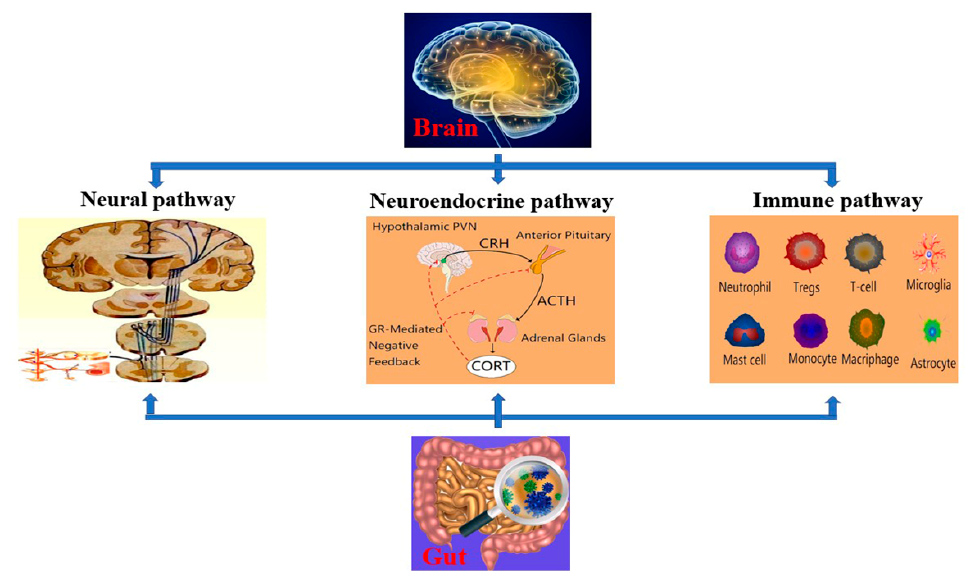
Figure 1. Schematic representation of the 3 pathways (neural, neuroendocrine and immune) that constitute the brain–gut axis. (1). Neural pathway: the brain regulates gut function mainly through ANS, while the gut microbiome exerts a feedback effect on the brain. (2). Neuroendocrine pathway: stimulation of the brain is transmitted to the gut via the HPA axis, while the gut microbiome influences the brain by affecting the production of immune mediators to activate the HPA axis. (3). Immune pathway: the brain causes gut dysfunction via releasing proinflammatory cytokines to recruit other immune cells, while the gut microbiome disrupts BBB integrity by downregulating TJs expression.